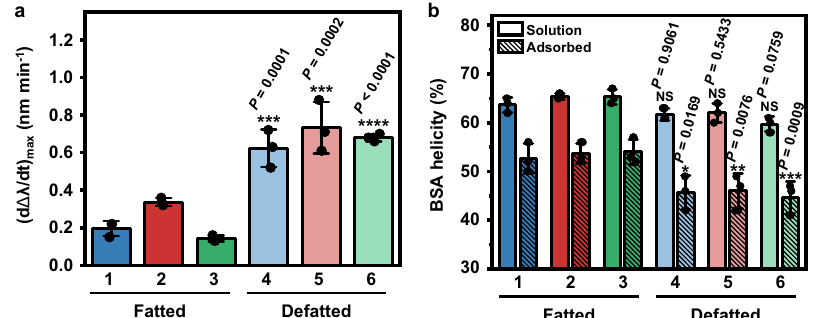
Fig. 4 Evaluation of adsorption-related conformational changes in BSA protein structure. a Maximum rate of change in the LSPR wavelength shift (d Δ λ /dt) max during the initial adsorption stage. Values are computed from data in Fig. 3f. Data are reported as mean ± s.d. ( n = 3 biological replicates, one- way ANOVA with Tukey ’ s multiple comparisons test). b Fractional percentage of α -helicity in BSA protein molecules in solution and in the adsorbed state, as determined in ATR-FTIR spectroscopy experiments. Data are reported as mean ± s.d. ( n = 3 biological replicates, two-way ANOVA with Tukey ’ s multiple comparisons test). P values are reported for defatted BSA proteins (versus fatted BSA proteins from the same fractionation method) in ( a ), and are separately reported for defatted BSA proteins in solution (versus fatted BSA proteins in solution from the same fractionation method) and for defatted BSA proteins in the adsorbed state (versus fatted BSA proteins in the adsorbed state from the same fractionation method) in ( b ). Dots represent individual data